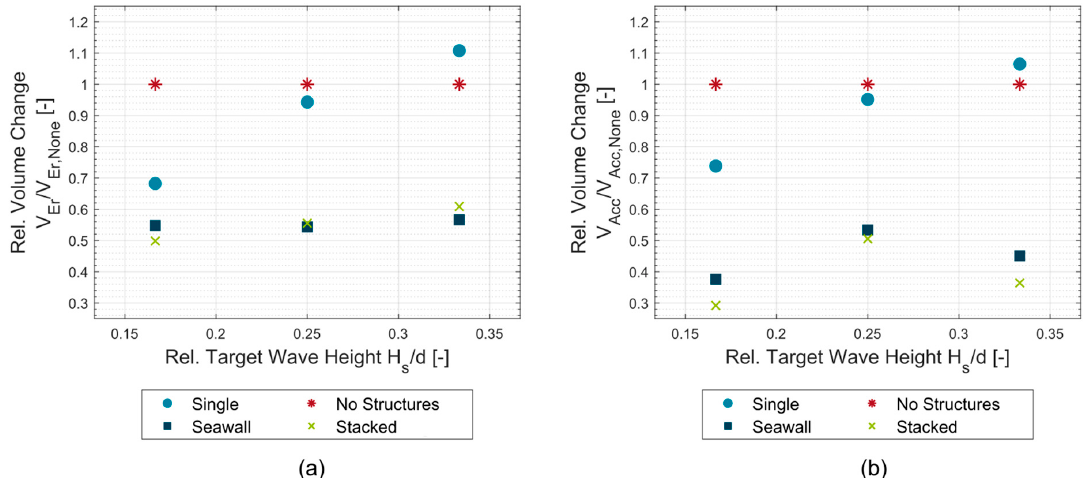
Figure 12. Relative volumetric changes caused by each structure in relation to the beach with No Structures , divided into ( a ) eroded volume, and ( b ) accreted volume.